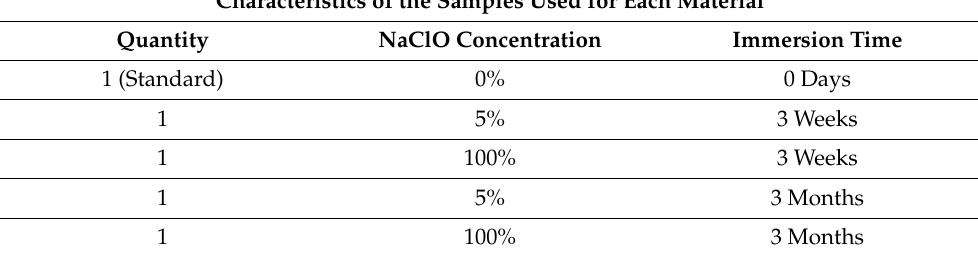
Table 2. Characteristics of the samples used for each material, regarding the concentration of NaClO and their immersion time. Characteristics of the Samples Used for Each Material Quantity NaClO Concentration Immersion